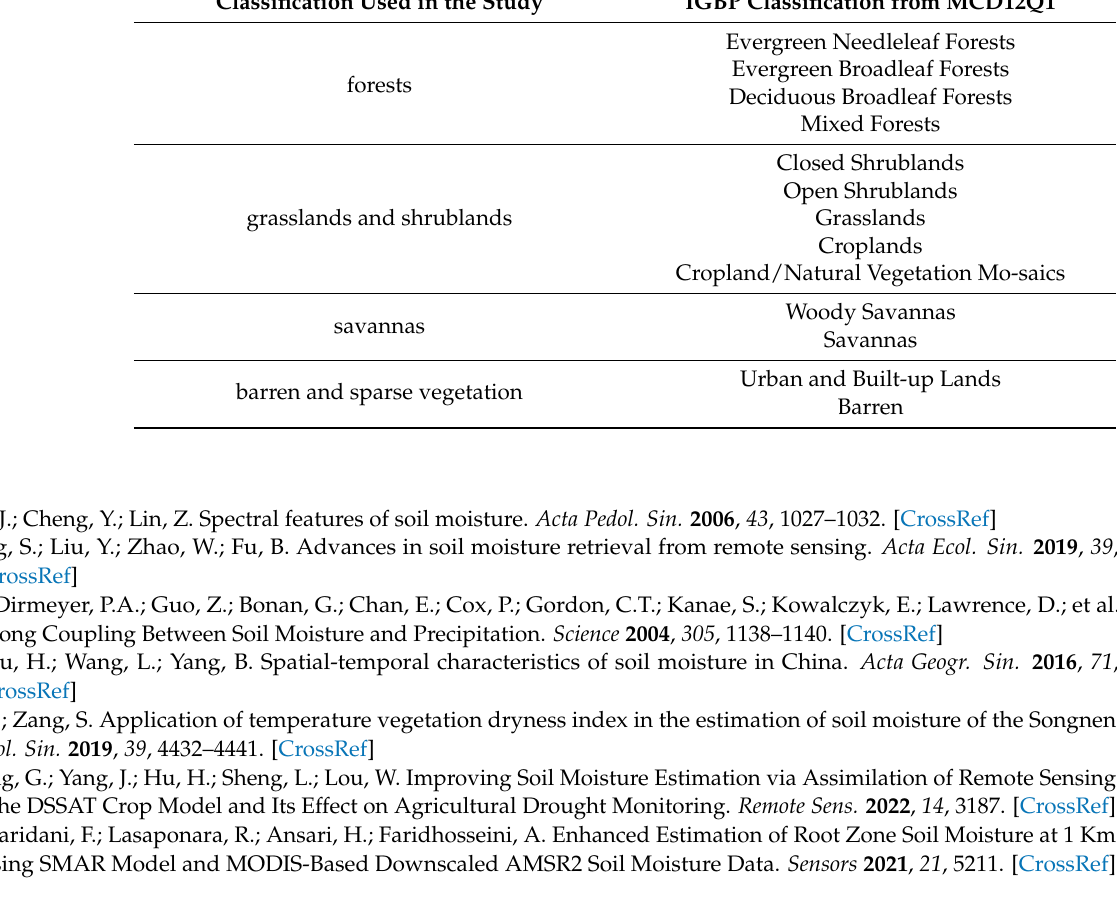
Table A1. Table of classification comparison. Classification Used in the